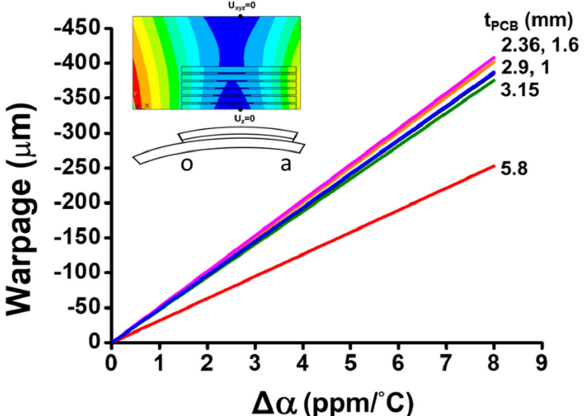
Figure 22. The effects of the thickness of the PCB (t PCB ) and mismatch of CTE ( ∆ α ) on thermally induced warpages of the PCB specimen with six sockets along the socket lines (line o-a) from the FEM simulation for Δ T= 30 °C − 180 °C = − 150 °C.